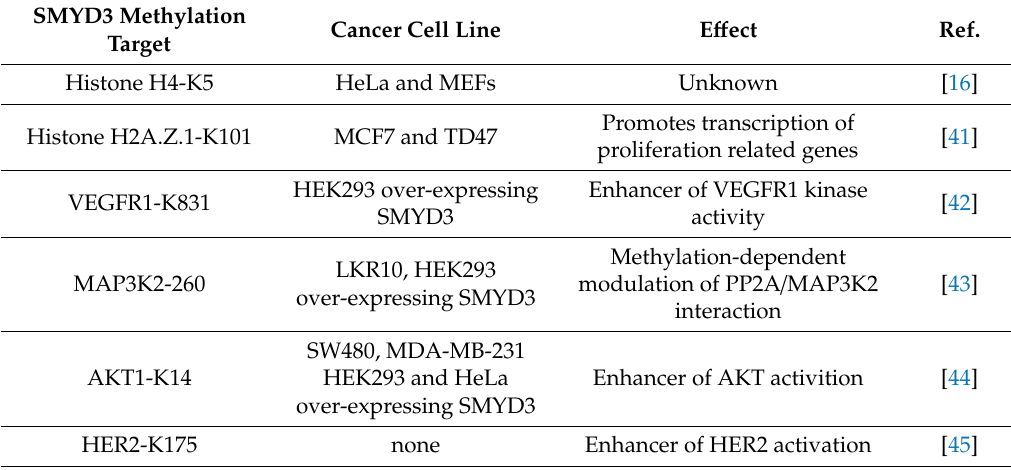
Table 2. Summary of SMYD3 methylation